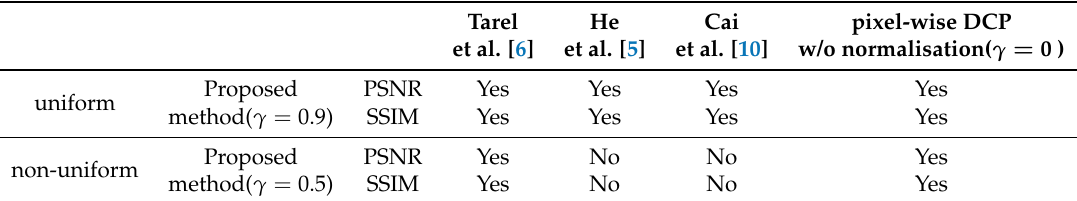
Table 3. Paired t -test results between proposed method and conventional methods. The statistically significant methods (p < 0.05) are indicated by “Yes” and others are indicated by “No”. Tarel He Cai pixel-wise DCP et al. [6] et al. [5] et al. [10] w/o normalisation( γ = 0